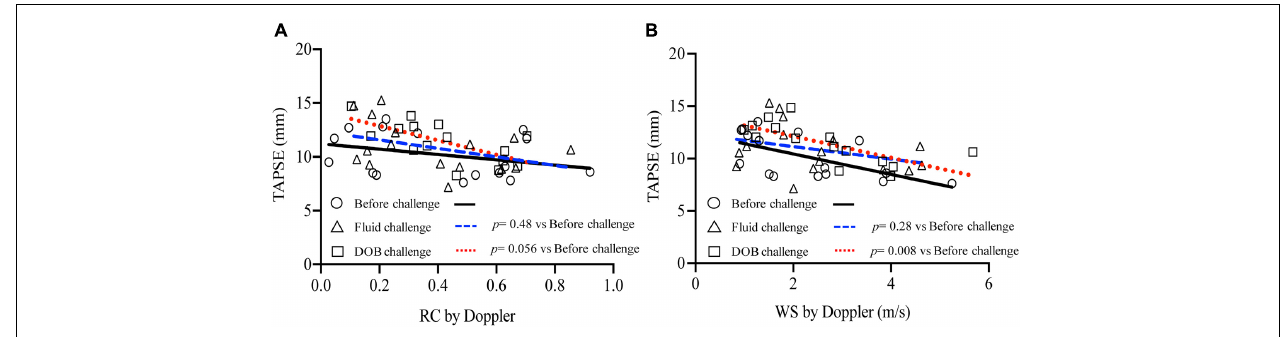
FIGURE 5 | Relationship between wave reflection and arterial stiffness indices and RV systolic function. TAPSE was plotted against echo-Doppler derived RC (A) and WS (B) , with separate regression lines for data acquired before challenge (solid line), during fluid challenge (dashed line) and during dobutamine challenge (dotted